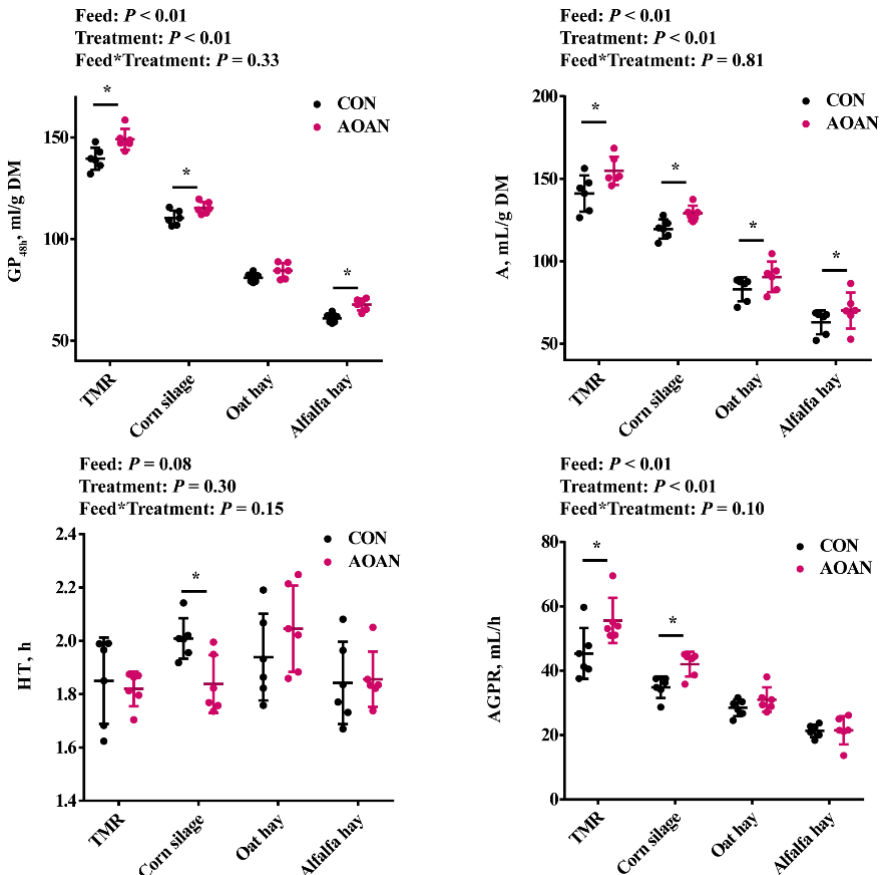
Figure 1. Effects of Aspergillus oryzae and Aspergillus niger co-cultivation fermentation extract on in vitro gas production kinetics parameters of a total mixed ration, corn silage, oat hay, and alfalfa hay. GP 48h , cumulative gas production at 48 h; A, ideal maximum gas production; HT, Time to reach half the ideal maximum gas production; AGPR, average gas production rate when half of the ideal maximum gas production was produced; CON, feedstuff fermentation with no additive using the in vitro gas production technique; AOAN, feedstuff fermentation with Aspergillus oryzae and Aspergillus niger co-cultivation fermentation extract using the in vitro gas production technique; *, p < 0.05; TMR, total mixed ration.